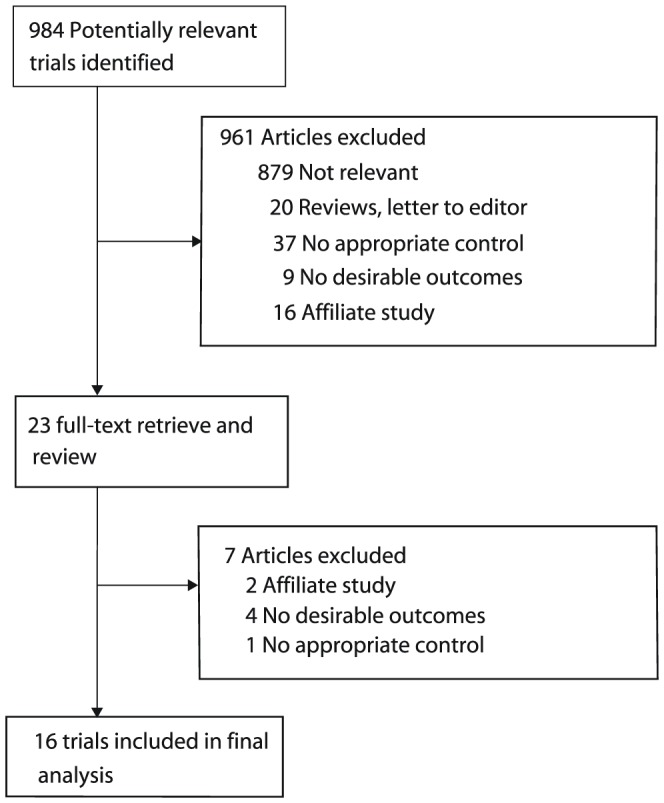
Identification process for eligible studies.